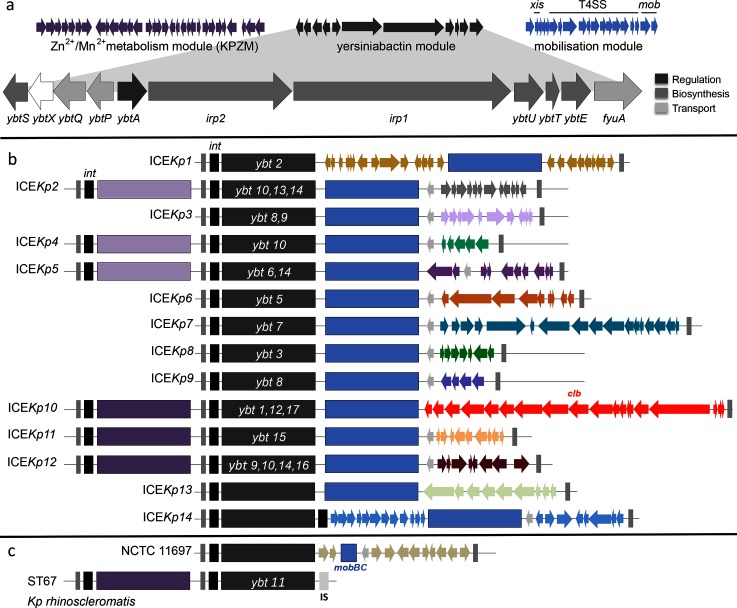
ICEKp structures. (a) Gene structure for core modules, which are shown in b and c as coloured blocks: yersiniabactin synthesis locus ybt (dark grey, labelled with the most commonly associated ybt lineage if one exists), mobilisation module (blue) and Zn2+/Mn2+ module (purple, usually present, light purple, rarely present). In a and b, the variable gene content unique to each ICEKp structure, which is typically separated from the mobilisation module by an antirestriction protein (light grey arrow), is shown in a unique colour as per Fig. 1. Grey rectangles represent direct repeats; black rectangles, P4-like integrase genes. Genes that make up the ybt locus are also shown and shaded according to their overall role in yersiniabactin synthesis (further details provided in Table S3). (b) Genetic structures of apparently intact ICEKp variants (see Table S6 and sequences deposited in GenBank for details of specific genes). (c) Disrupted ICEKp loci.